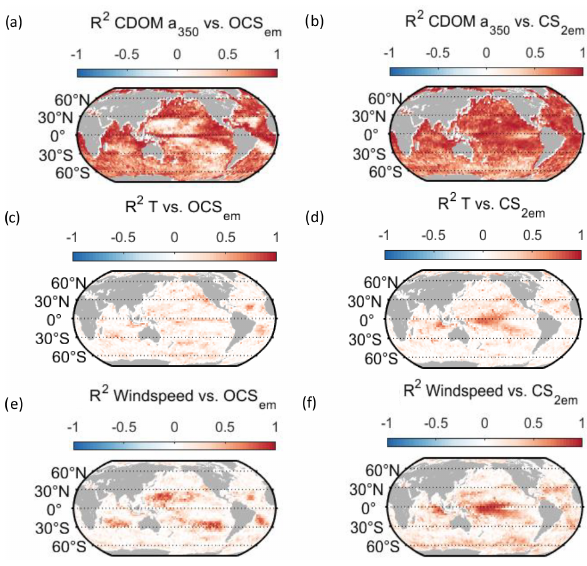
Figure 6. Regional correlation of annual OCS (a, c, e) and CS 2 (b, d, f) emission data with monthly data for temperature (a, b) , wind speed (c, d) , and CDOM absorption coefficient (e, f) . Correla- tion is shown as Pearson’s R 2